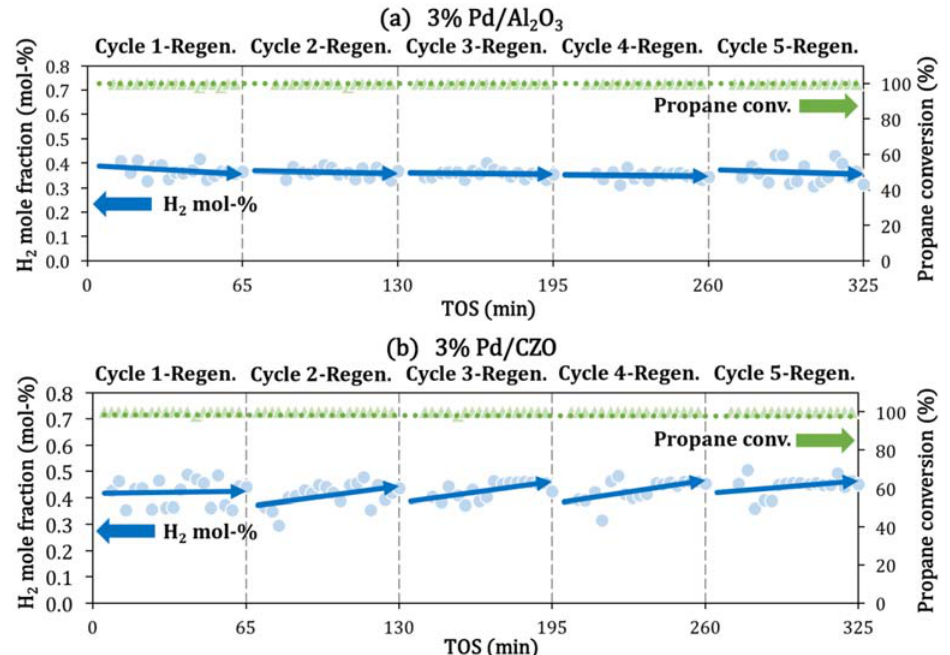
Figure 4. H 2 productions as a function of time on stream (TOS) during attempted regeneration processes in simulated fuel shutoff aging-attempted fuel rich regeneration cycle tests (First 5 cycles out of total 25 cycles) with ( a ) 3% Pd/Al 2 O 3 and ( b ) 3% Pd/CZO. In each cycle, the catalyst sample was first aged in air at 1050 °C for 5 min, followed by attempted in situ regeneration at fuel rich condition at 550 °C for 1